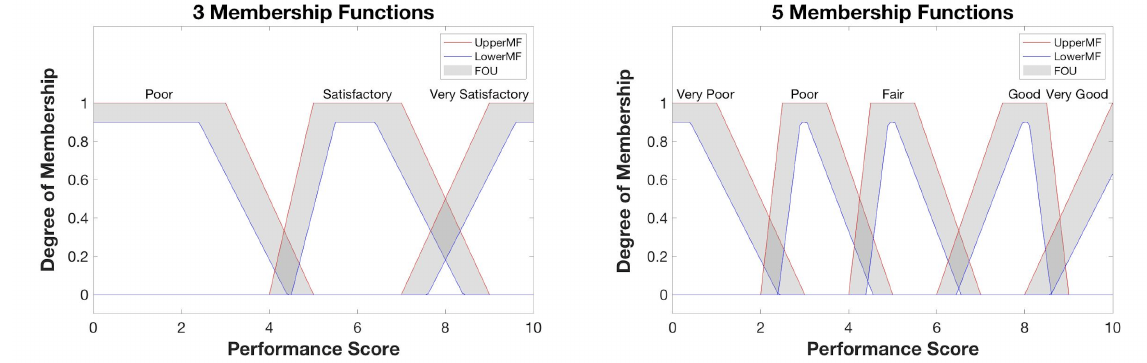
Figure 13. Membership functions for the performance score